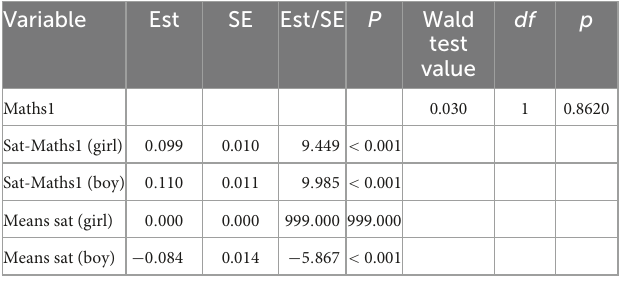
TABLE 4 Results of the moderation analysis for plausible value (PV) 1 mathematics